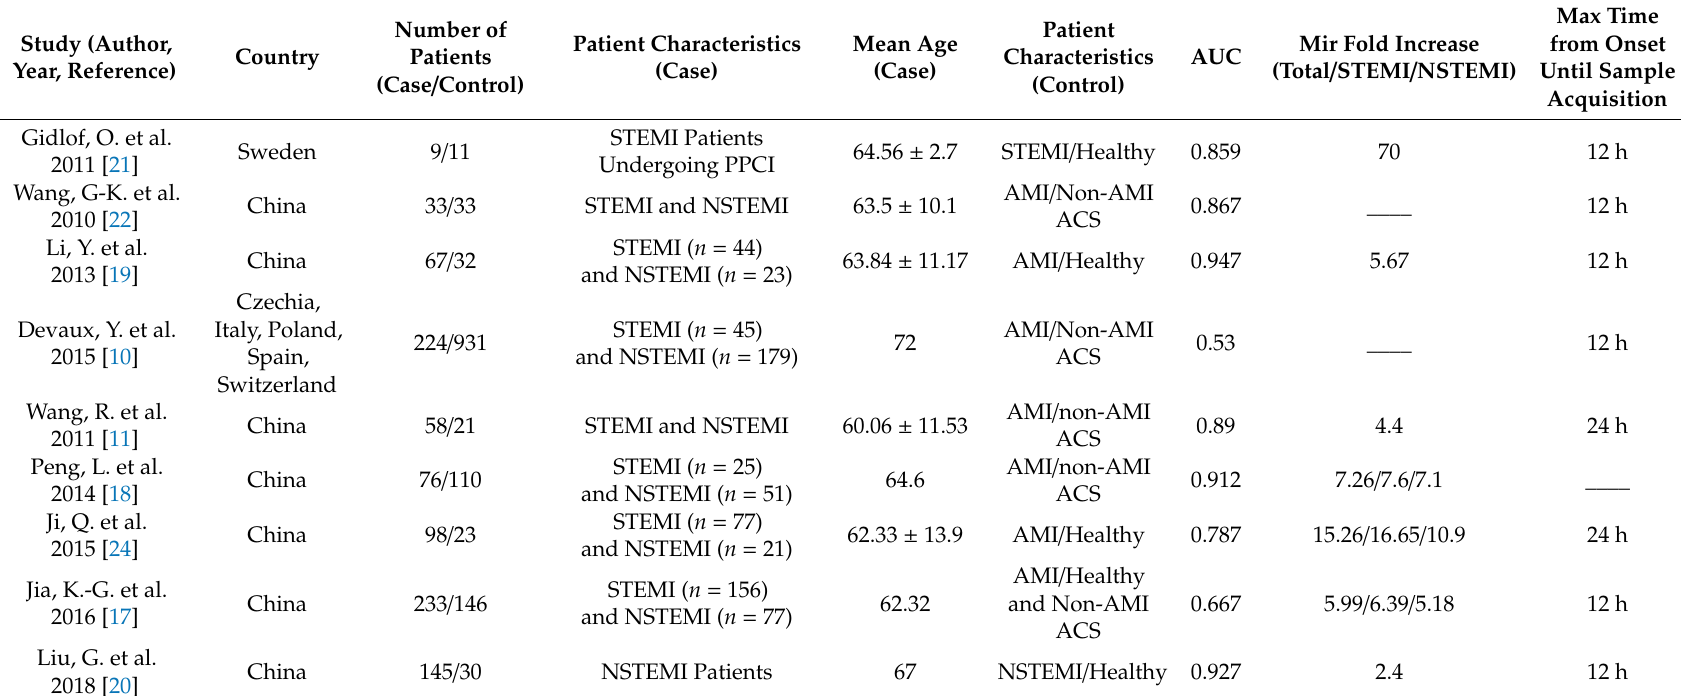
Table 1. Data summary from included